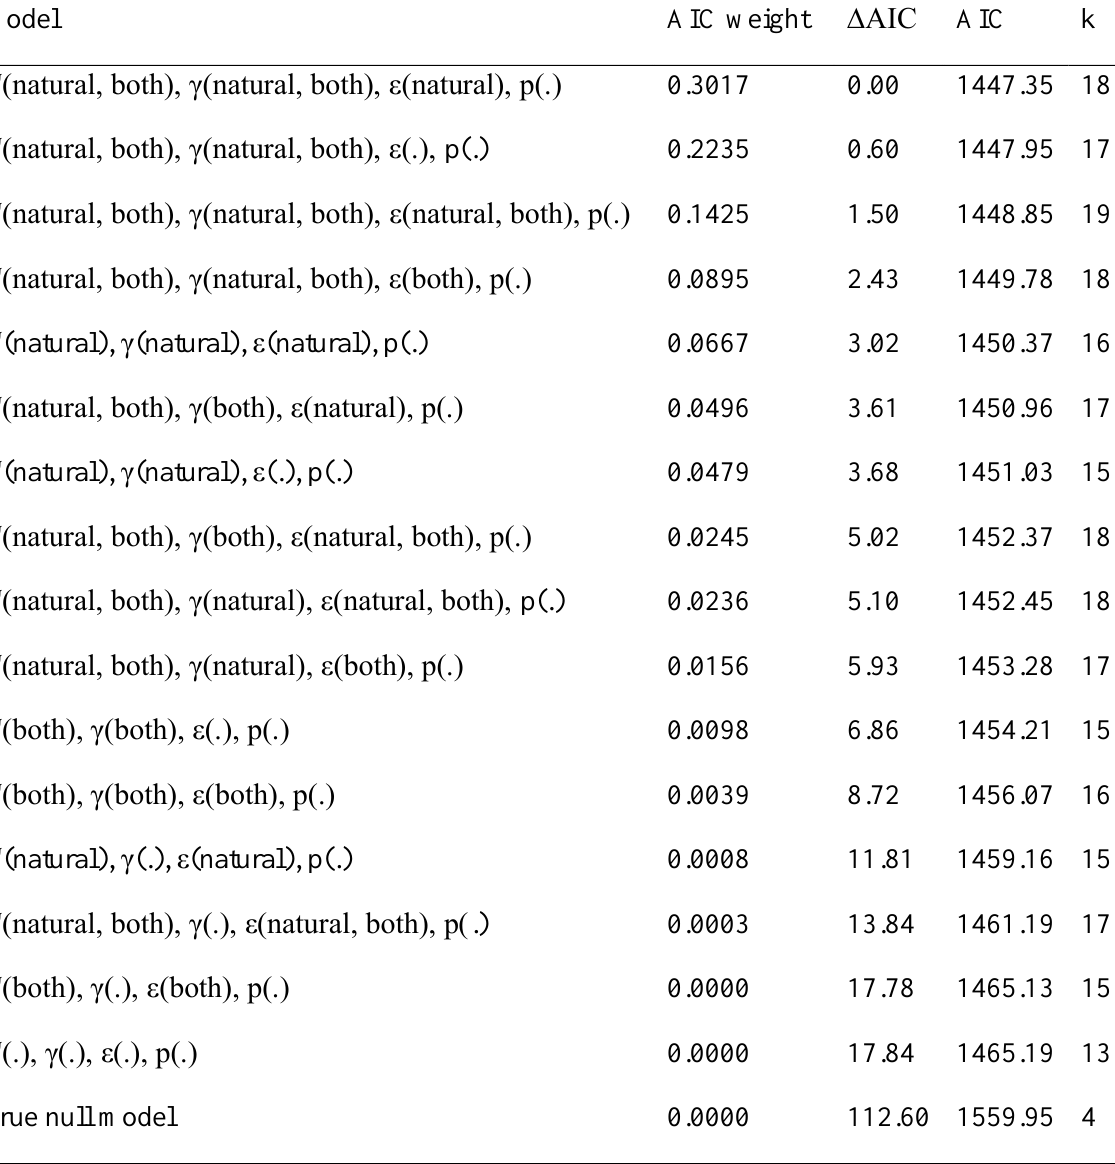
Table A1.4. AIC table for multi-season occupancy models for the Sierra Nevada foothills metapopulation of the California Black Rail ( Laterallus jamaicensis coturniculus ),